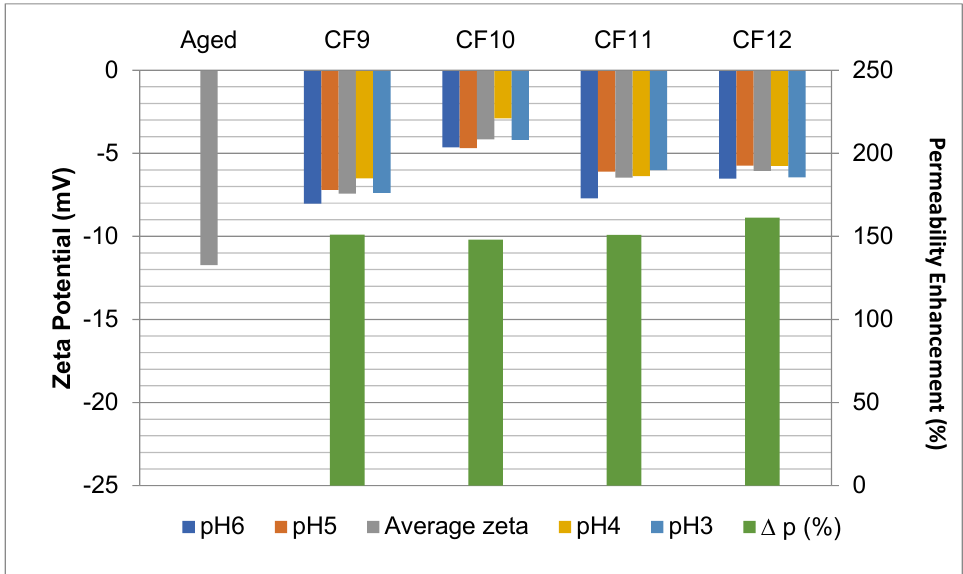
Figure 19. Zeta potential (pH3 to pH6) vs. permeability enhancement (category2).